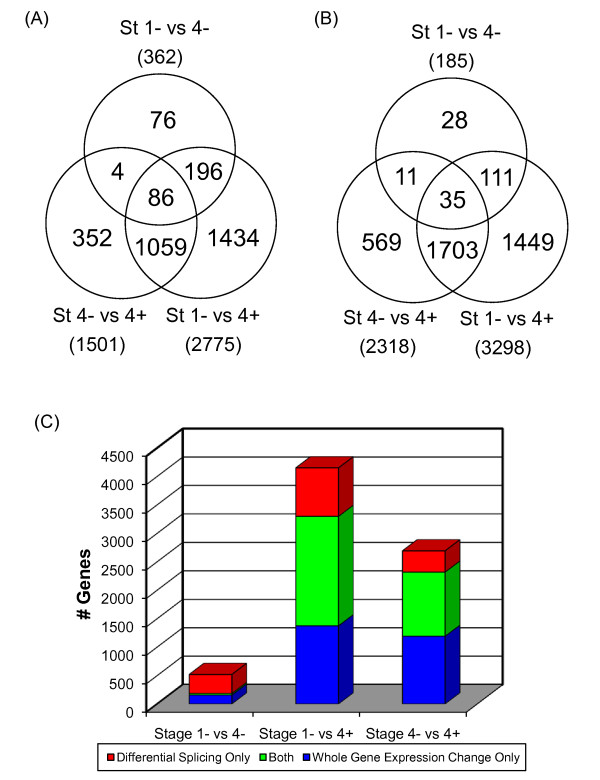
Comparison of exon level splicing change and gene level expression change. Pairwise comparison of stage 1-, 4-, and 4+ tumors was performed for both exon level splicing change and gene level expression change; the genes with FDR < 0.05 were identified. (A) Venn diagram of alternatively spliced candidate genes. (B) Venn diagram of differentially expressed candidate genes. (C) Comparison of exon level splicing change and gene level expression change. Blue column shows number of genes with whole gene expression change but not splicing change, while red column shows number of genes with splicing change but not whole gene expression change. Green column represents genes with both whole gene expression and splicing changes.